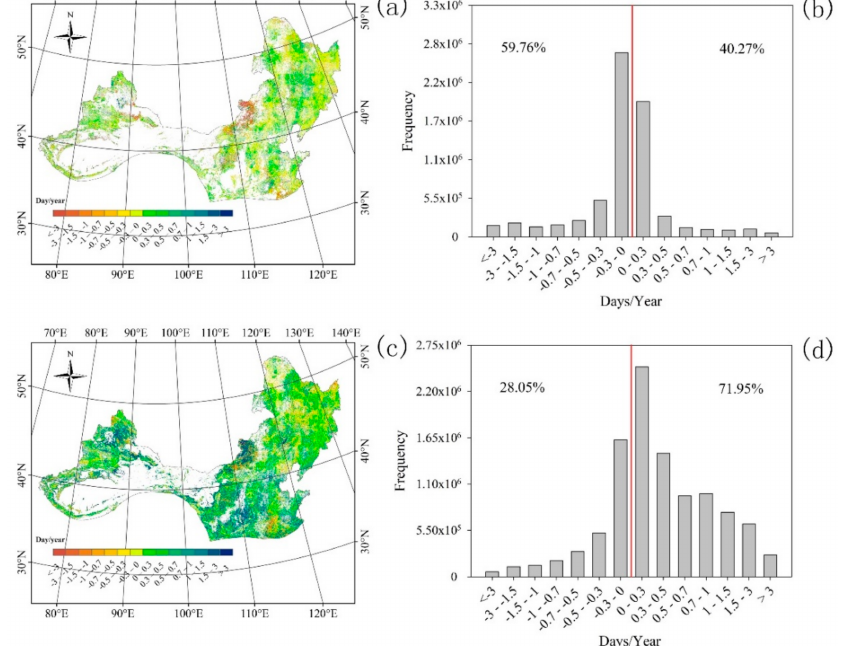
Figure 3. Isolated impacts of climatic factors ( a ) and non-climate change ( c ) on the variation in EOS. ( b , d ) are the corresponding frequency distributions for climatic factors ( a ) and non-climate change ( c ),